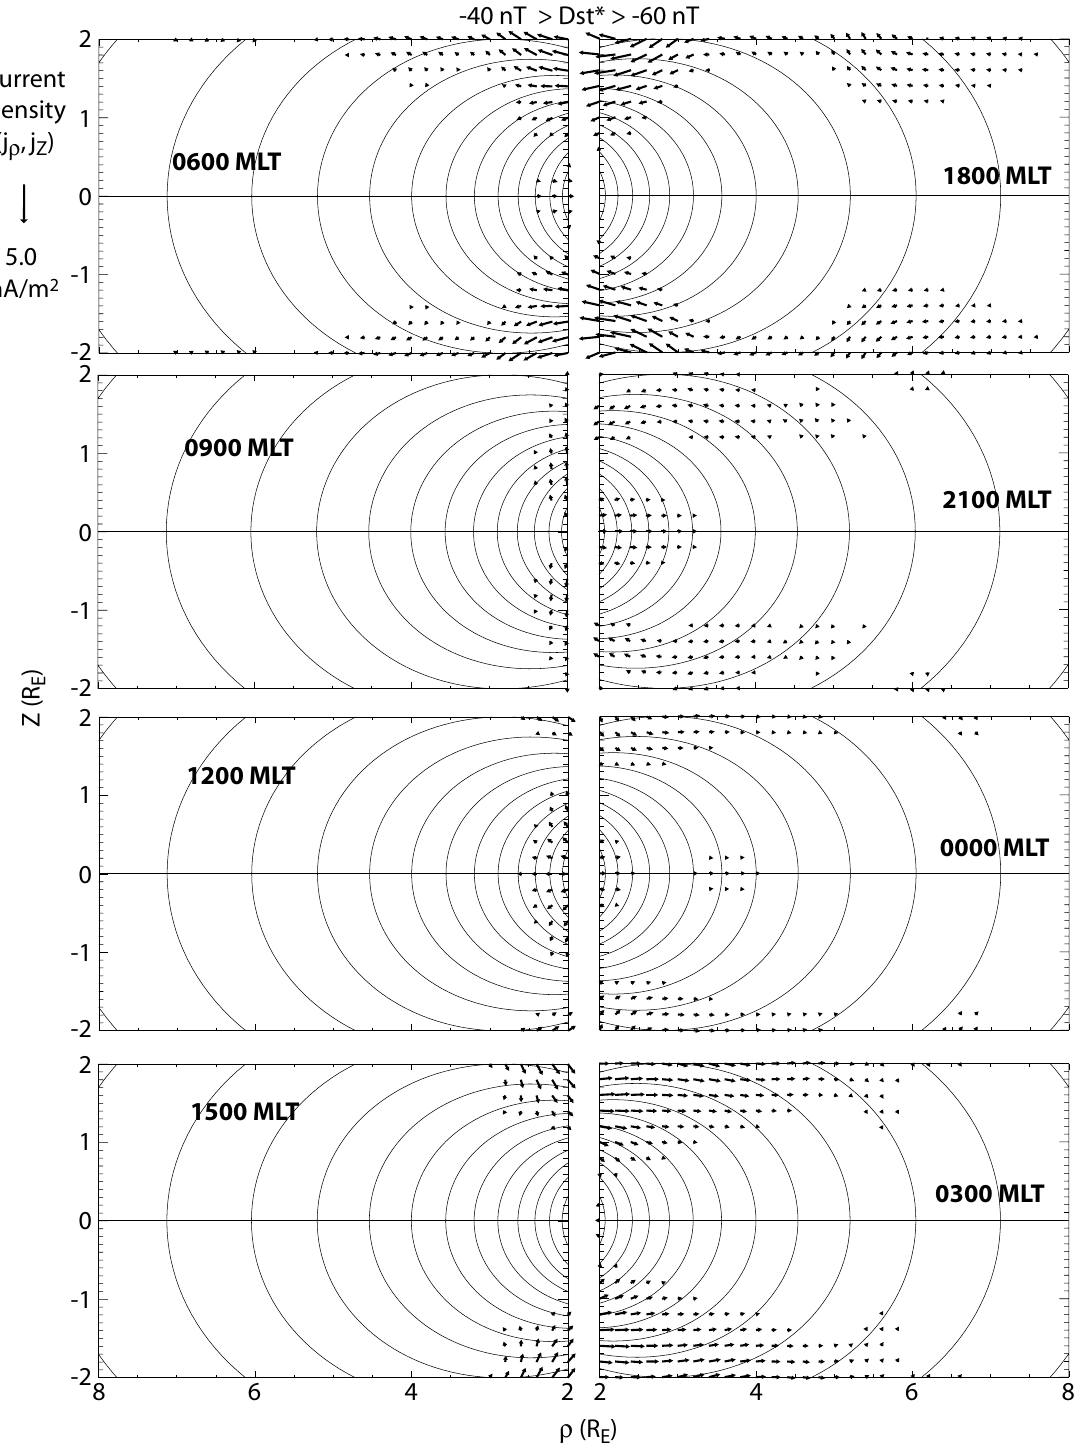
Fig. 10b. Meridional components of the current density as arrows in equally spaced grids in each of the 8 local time planes with superimposed dipole field lines for the four D st * levels. The scale factor for the current density is different for different D st *: (b) − 40nT >D st * > −